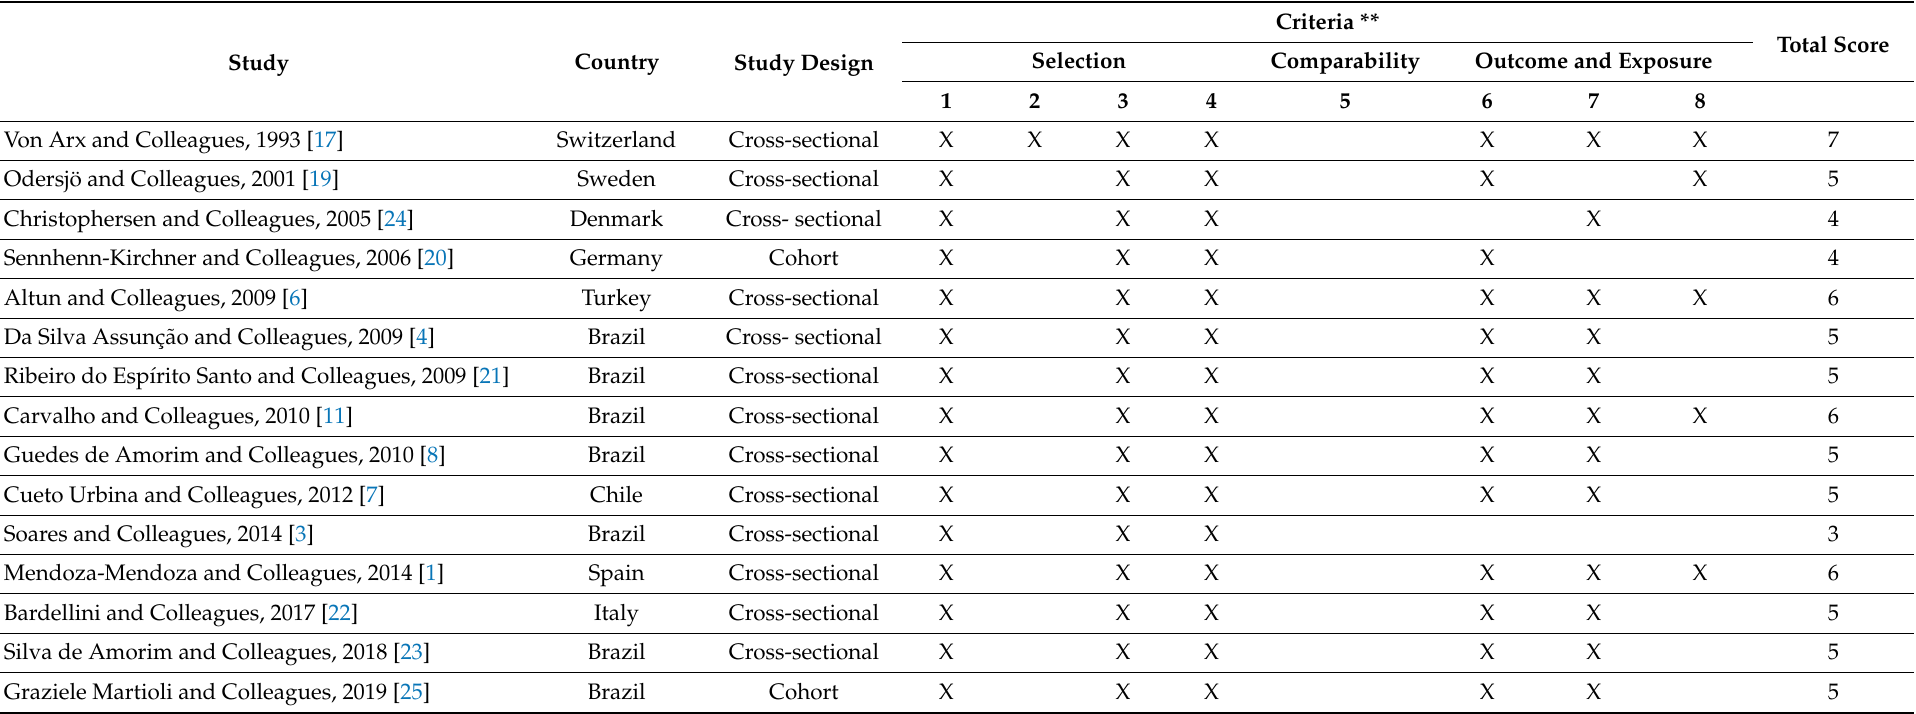
Table 1. Methodological quality for cross-sectional and cohort studies, assessed using the Newcastle-Ottawa Scale *.